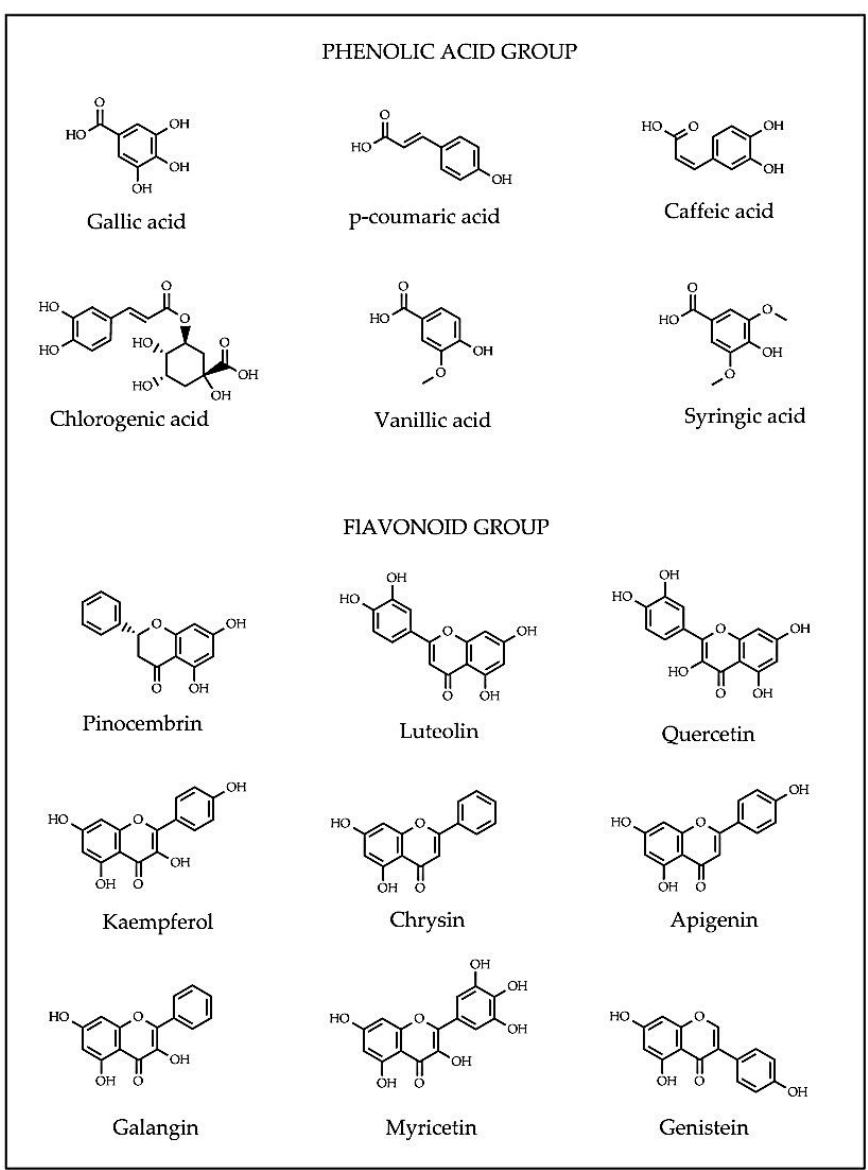
Figure 2. Common phenolic acid and flavonoid compounds identified in honey.